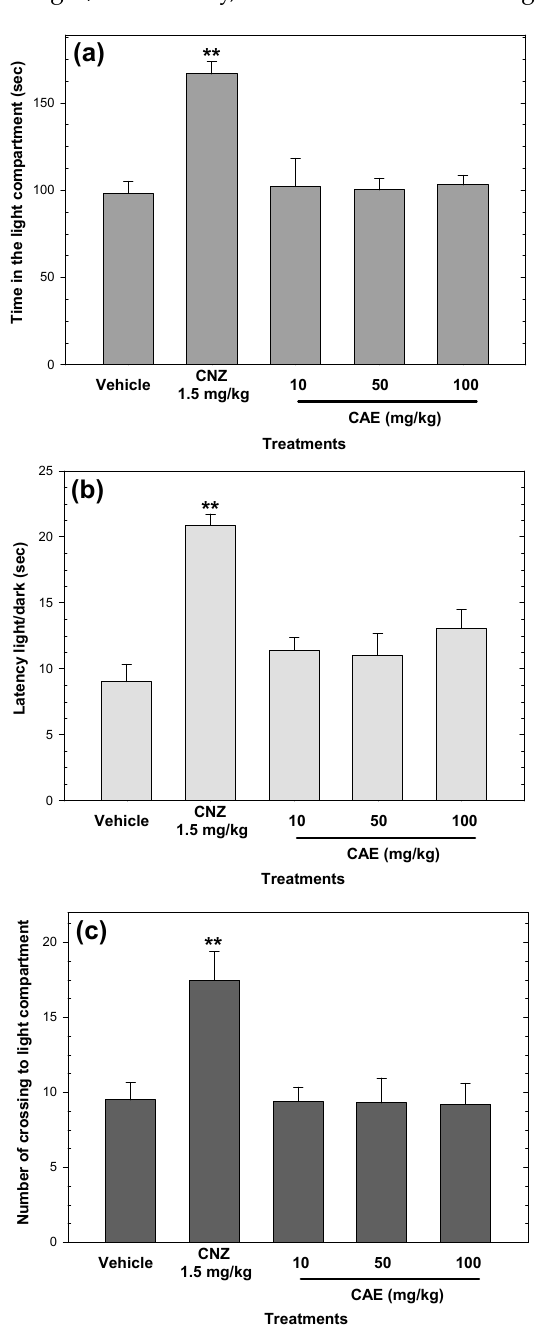
Figure 2. Anxiolytic-like actions of CAE (10–100 mg/kg p.o.) in the light/dark test were evaluated by the time spent in the light compartment ( a ), light/dark latency ( b ), and the number of crossings into the light compartment ( c ). Clonazepam (CNZ) at 1.5 mg/kg p.o. was used as the positive control. Bars represent mean values (± SEM) for the experimental group. n = 8, ** p < 0.05 compared to the vehicle group.